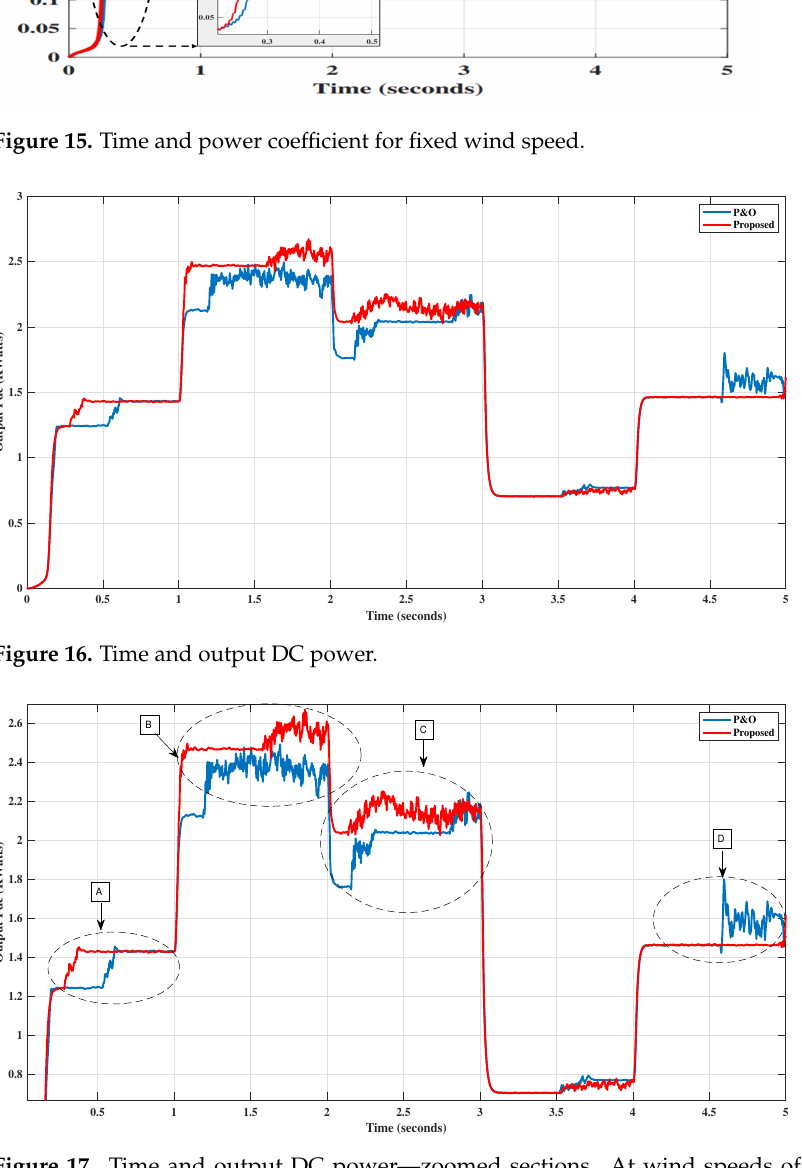
Figure 17. Time and output DC power—zoomed sections. At wind speeds of 10 m/s, 12 m/s, and 11 m/s denoted by sections A, B, and C, the power obtained for the proposed algorithm is considerably greater than that obtained for the CPO method. For sections A, B, and D, the oscillations are also found to be